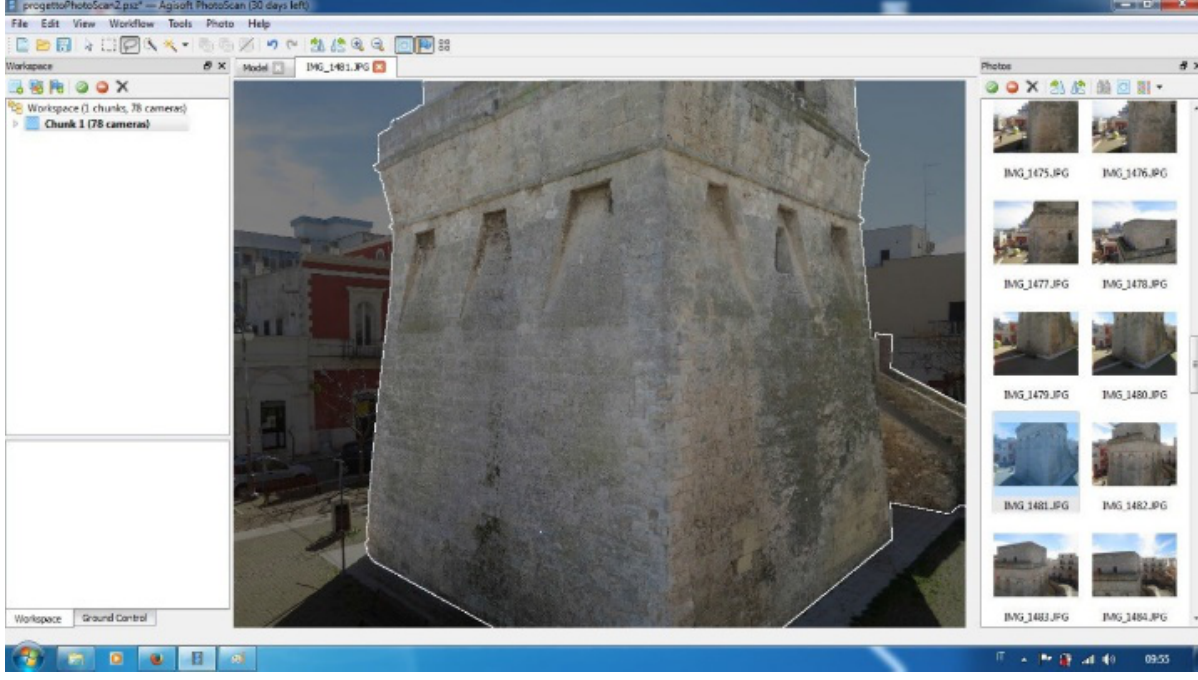
Figure 7: Cloud points and texture using Agisoft